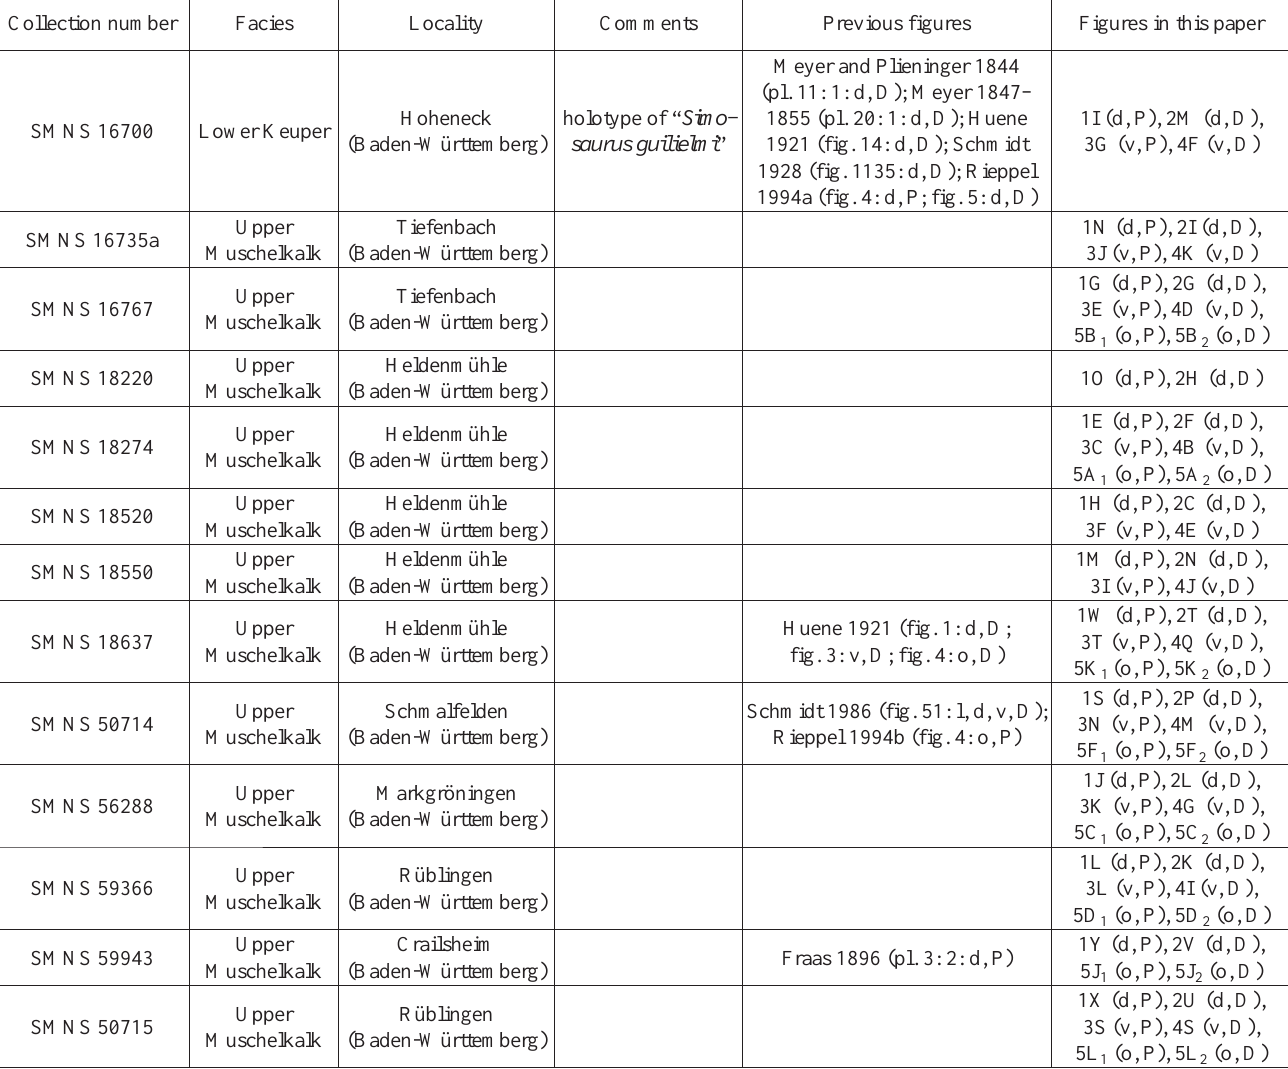
Huene 1921 (fig. 1: d, D; fig. 3: v, D; fig. 4: o,